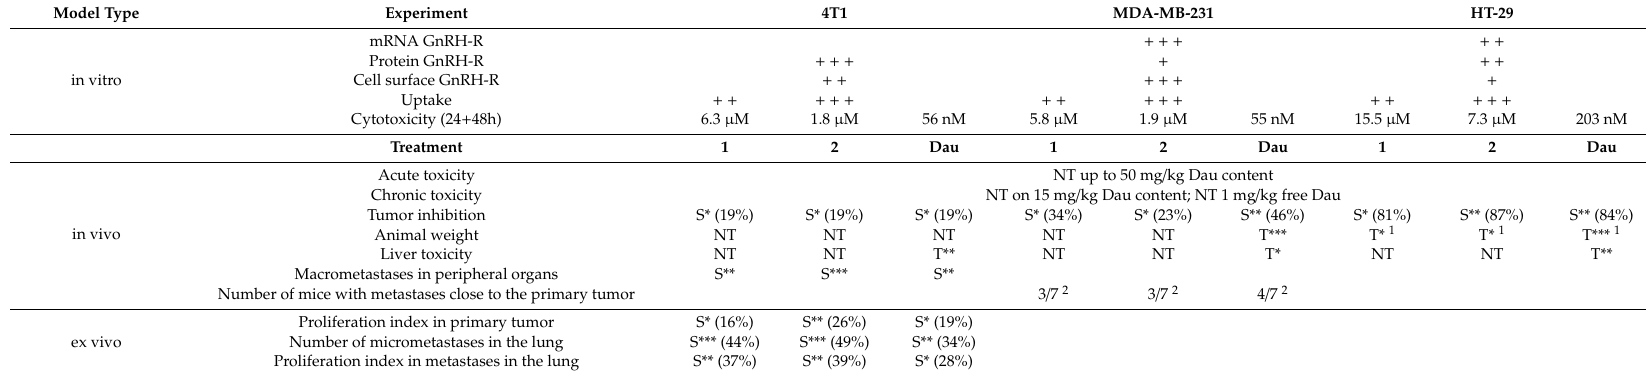
Table 3. Summary of GnRH-R expression level and e ff ect of free drug Dau and GnRH-III-Dau conjugates 1 and 2 on 4T1, MDA-MB-231 and HT-29 in in vitro, in vivo and ex vivo